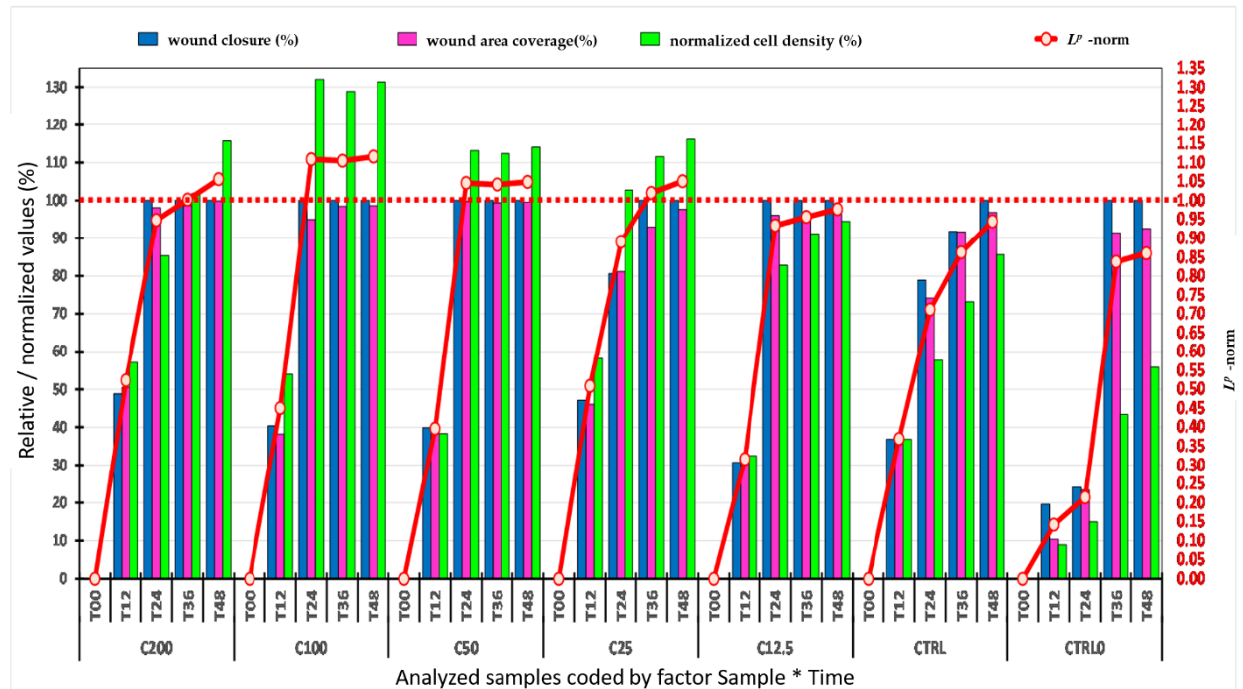
Figure 6. Evolution over time, of the average values of the widths ( µ m) of the wound, the areas (mm 2 ) of the wound, of the normalized densities (%) of the cells inside the wound, and the L p norm, for all treatments. C200—12.5 µ g/mL represents the Stellaria media (L.) Vill extract concentrations applied, CTRL—positive control (allantoin—50 µ g/mL), CTRL0—control (without treatment), where no treatment was applied. T00 – T48 represents the time expressed in hours.